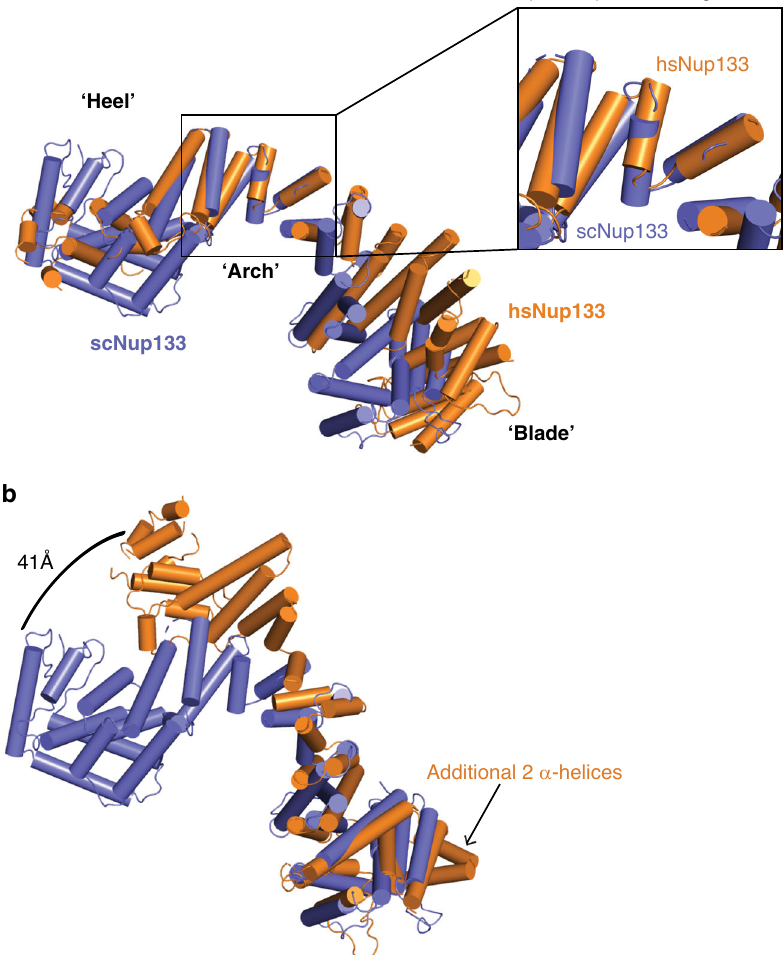
Fig. 3 Comparison between scNup133 CTD and hsNup133 CTD . a Superposition of hsNup133 (orange, PDB: 3I4R) and scNup133 (purple), using the arch element for matching. Inset zooms in on the arch where scNup84/hsNup107 bind. b Same superposition as in a , but using the blade element for matching. Arrow indicates additional helices in the hsNup133 blade domain. This superposition emphasizes the large, 41 Å conformational shift between the two heel